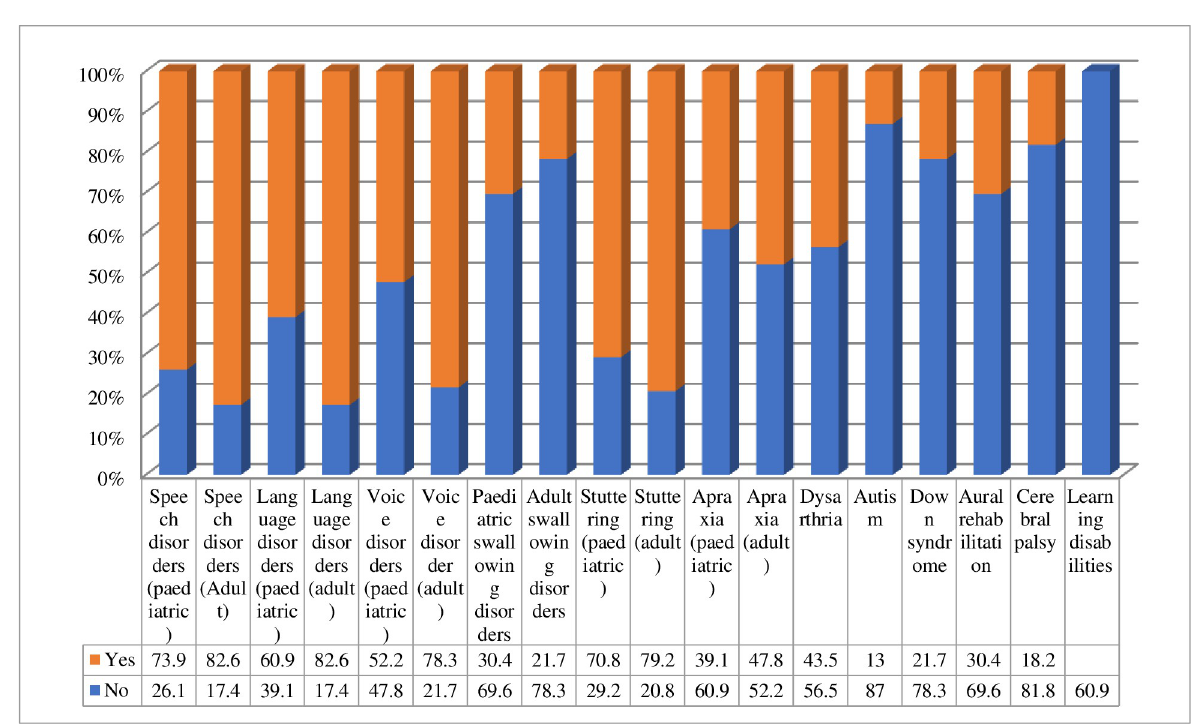
Fig 3. Areas of practice where telehealth can replace conventional speech therapy in the future (n =